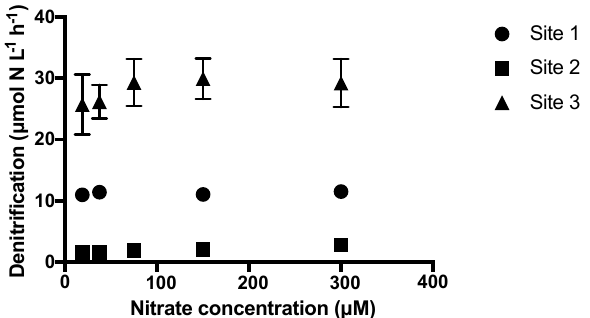
Figure 2. Denitrification rates as a function of nitrate concentration at the inlet of the columns at the three sites studied. Error bars for sites 1 and 2 are smaller than the marker